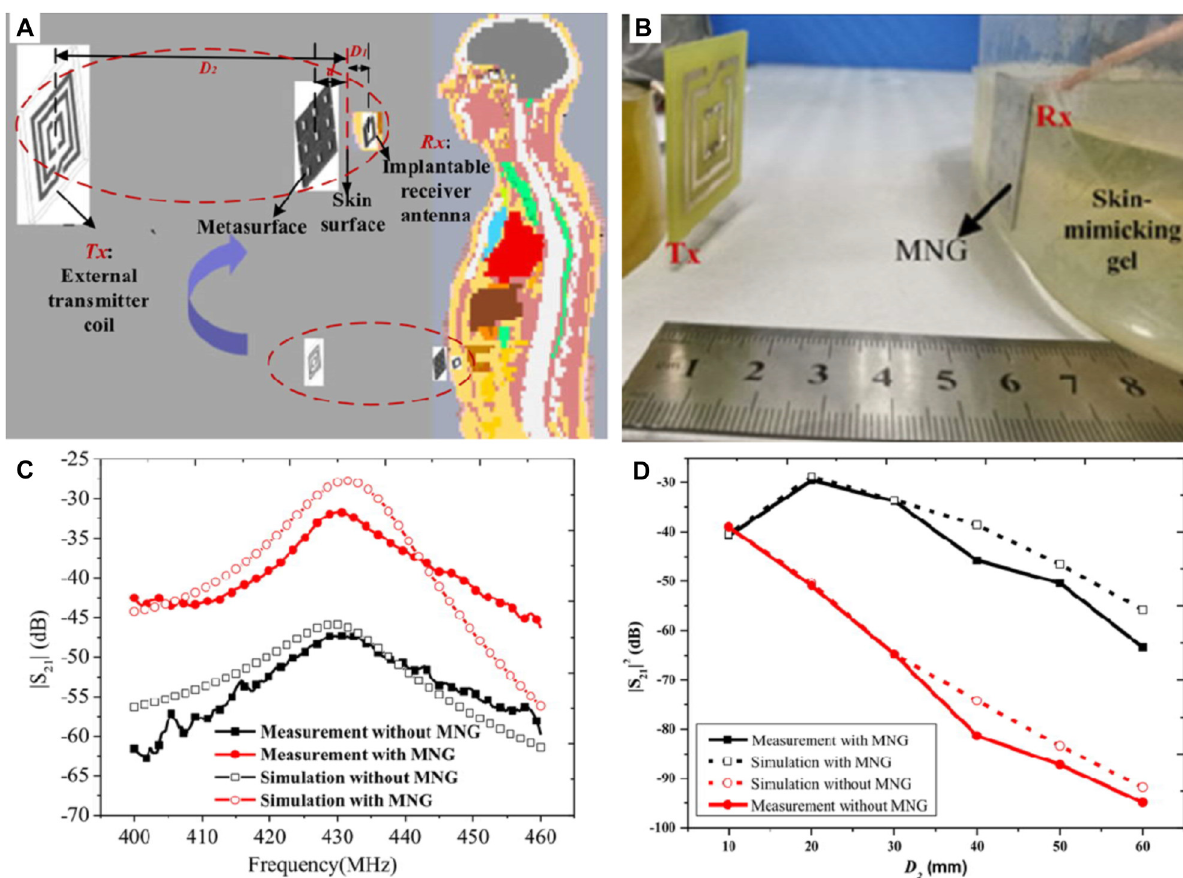
Figure 13: Implantable metamaterials for coupling WPT.